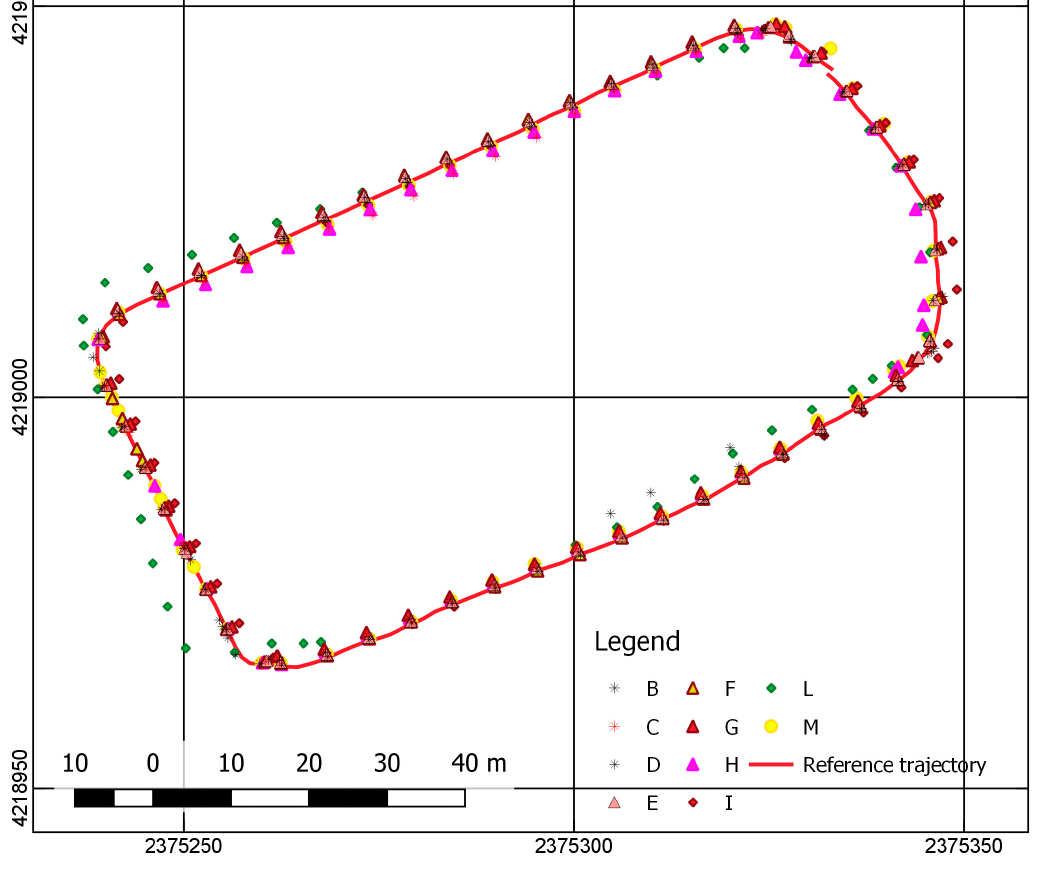
Table 2. Summary statistics for distance 1 .